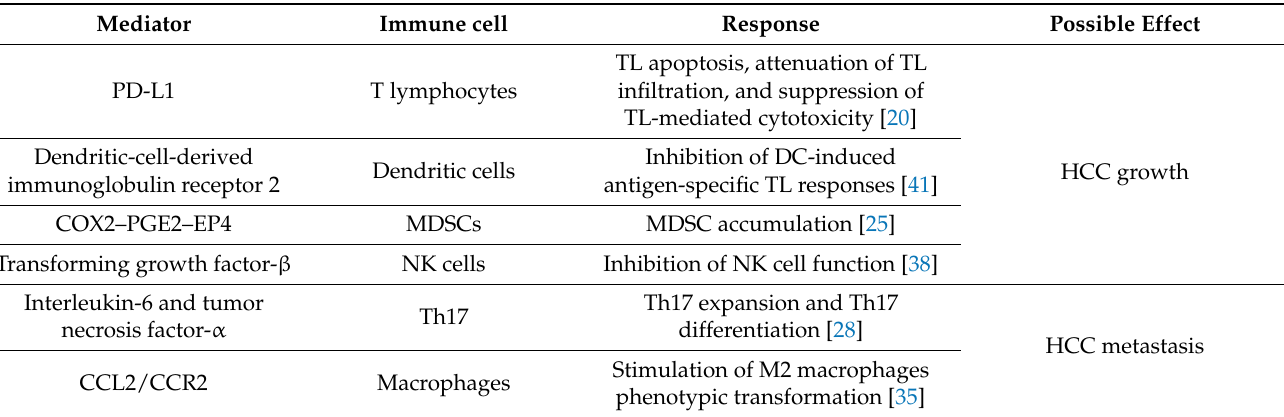
Table 1. Immunosuppressive functions of HSCs.